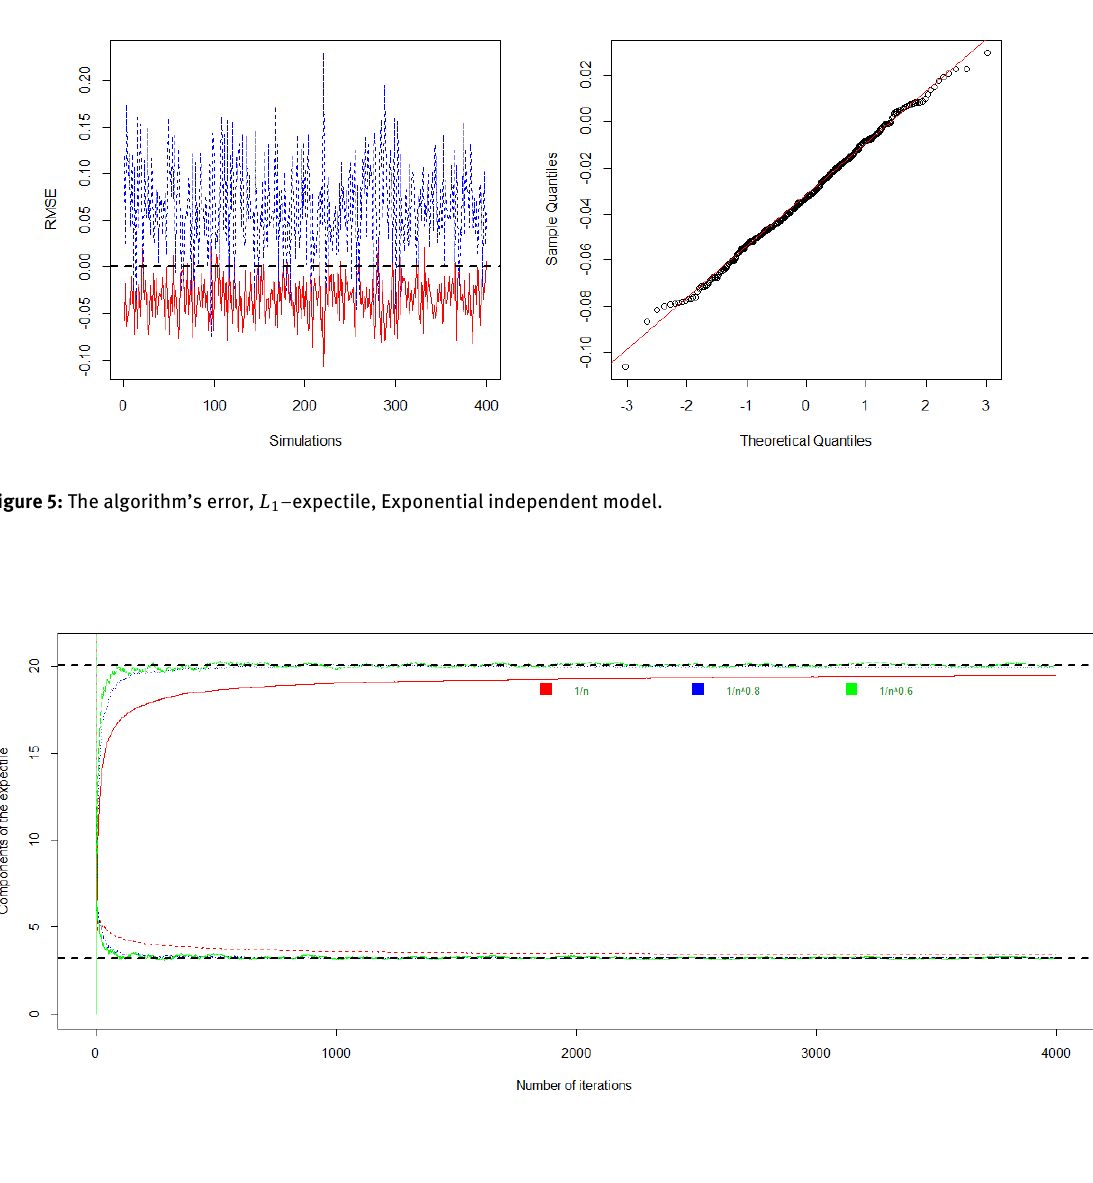
Figure 6: Impact of the choice of the sequence of steps on the